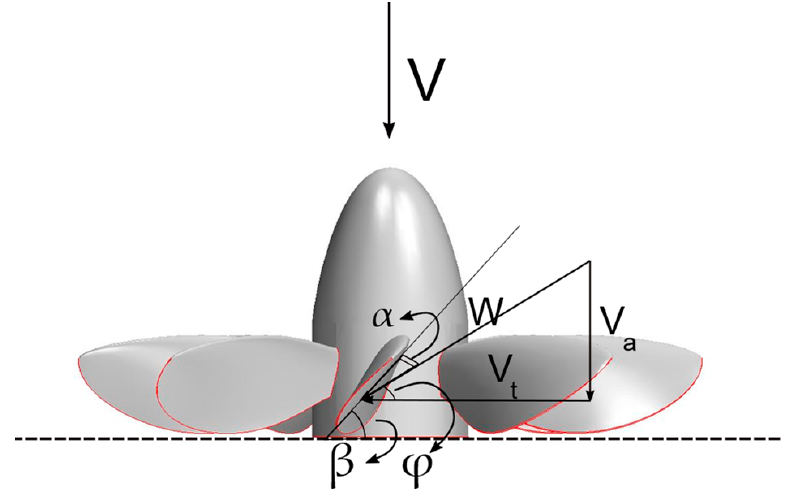
Figure 7. Blade geometry definition and velocity of interest: α is AoA for the blade element, β is the geometric pitch angle, ϕ is the helix angle, V t is the tangential velocity component, V a is the axial velocity component, and W is the resultant velocity. Table 6. DEP and TIP propeller geometries (r, blade station, R, blade radius, c, blade local